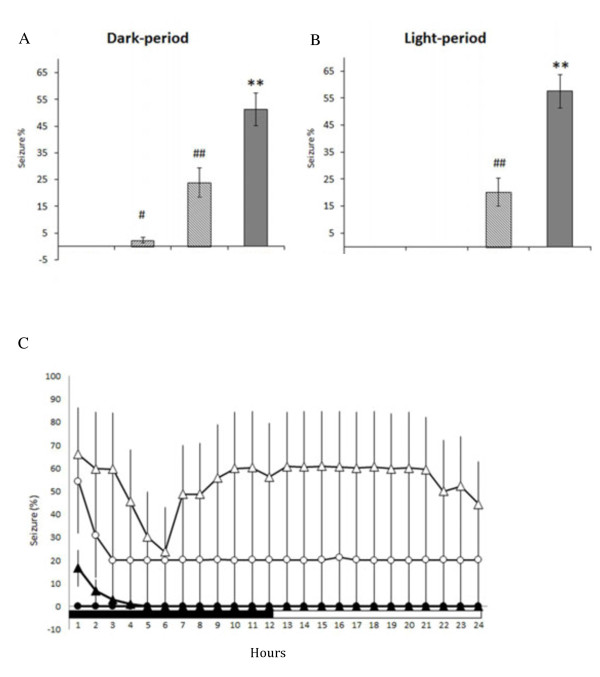
The summary of 100 Hz EA stimulation of bilateral Feng-Chi acupoints on the epileptic activities. Panel A depicts the results obtained from the dark period and panel B demonstrates the data acquired from the light period. The bars from the left to the right in both panels A and B represent the results obtained from the naïve rats, the EA group, the pilocarpine group, and the PFS + EA + pilocarpine group. In panel C, the black circles represent the values obtained from the naïve group, the black triangles depict the results of the EA group, the white circles demonstrate the values obtained from the pilocarpine group, and the white triangles indicate the data acquired from the PFS + EA + pilocarpine group. #: p < 0.05 vs. the naïve rats; ##: p < 0.01 vs. the naïve rats; **: p < 0.01 vs. the pilocarpine group.